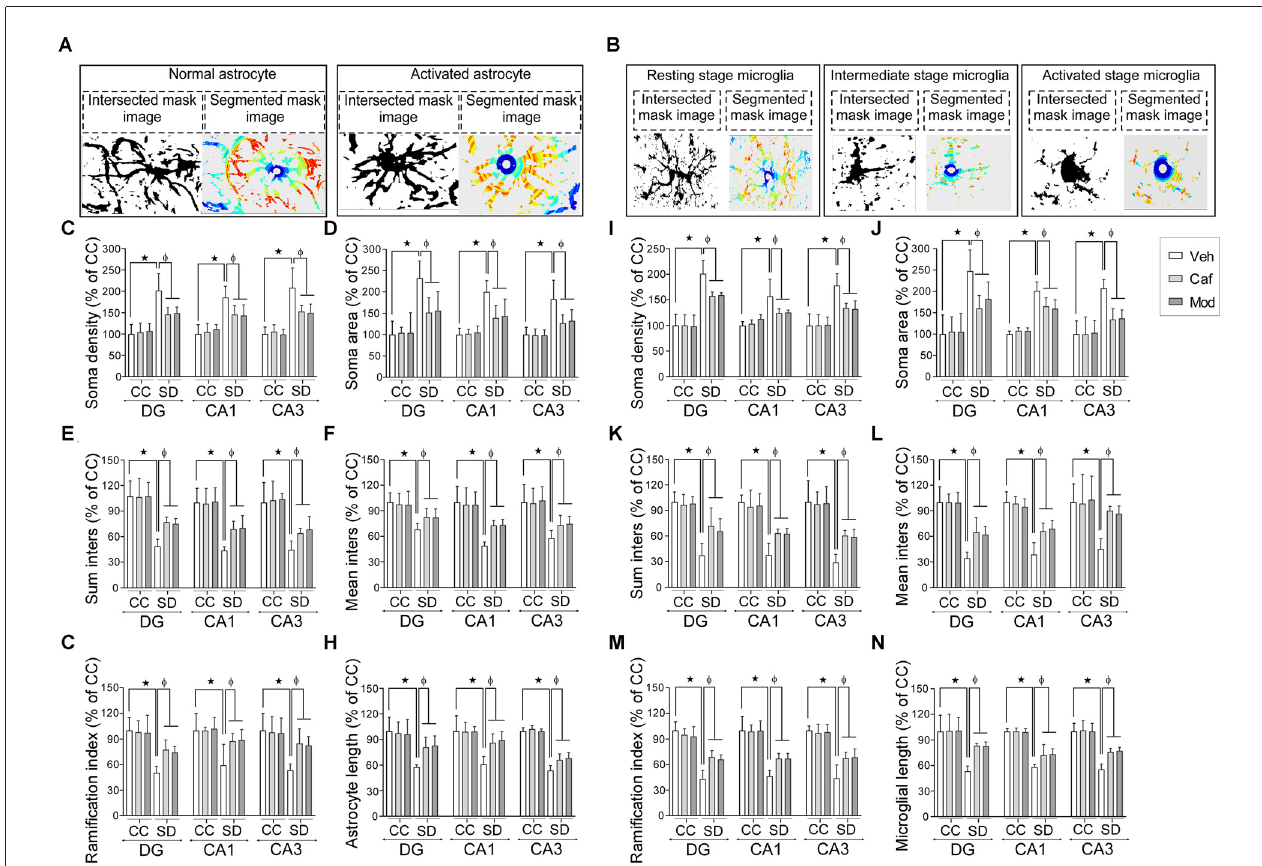
FIGURE 6 | Caffeine or modafinil administration altered the morphology of astrocytes and microglia towards the resting state in rat hippocampus during SD. Representable image (intersection and segmented mask) of (A) normal and activated astrocyte; (B) resting, intermediate and activated stage microglial cell. Changes in the (C) soma density; (D) soma area; (E) sum inters; (F) mean inters; (G) ramification index; (H) astrocyte length of astrocytes in DG, CA1 and CA3 regions of the hippocampus. Changes in the (I) soma density; (J) soma area; (K) sum inters; (L) mean inters; (M) ramification index; (N) microglial length of microglia cells. ∗ p < 0.05 when compared to control treated with vehicle; φ p < 0.05 when compared to sleep deprived treated with vehicle. Two way ANOVA followed by Tukey post hoc test with multiple comparison was applied for statistical comparison between groups and for the graphical representation, values expressed mean percentage of Control ± SEM.